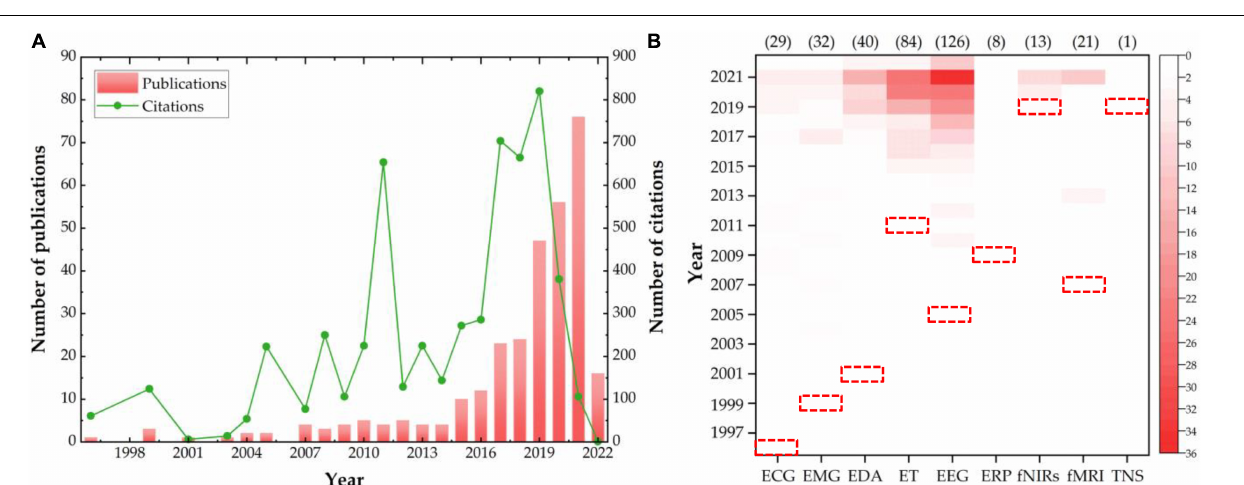
network based on the co-occurrence relationship of